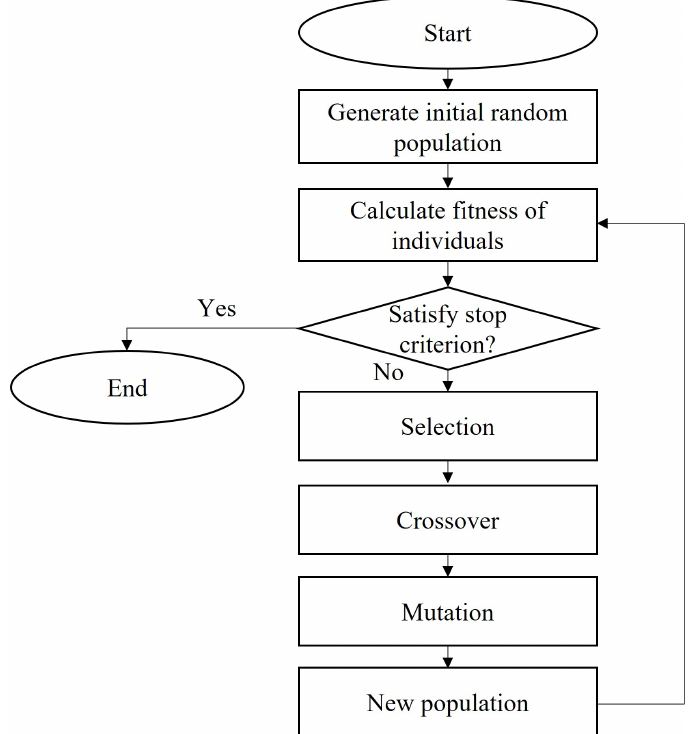
Figure 12. GA procedure